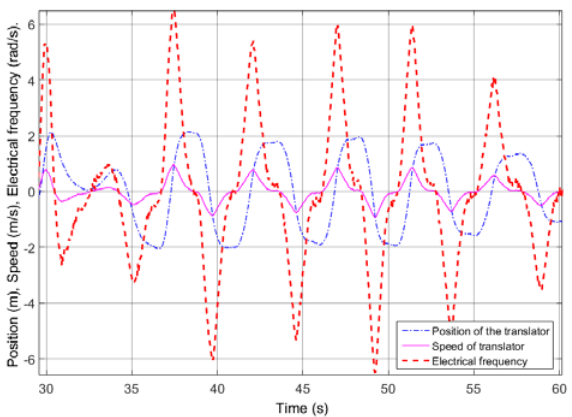
Fig 9. Position, speed, and electrical frequency of the translator in Case III.